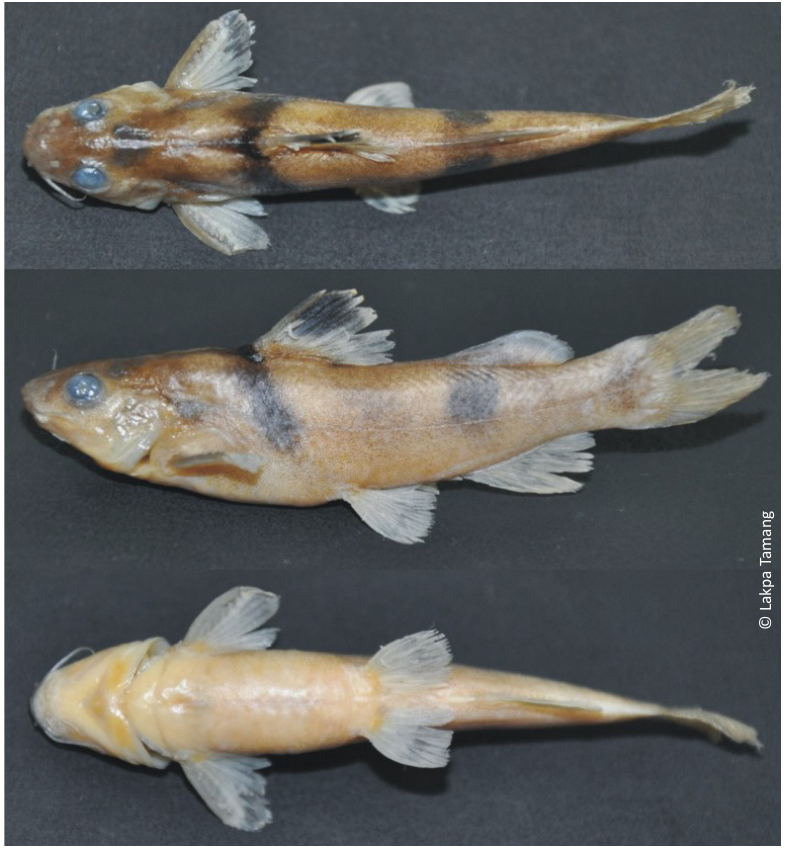
(Figs. 1, 1a-b) [type locality: pond at Mariani Junction, Assam, India, holotype, ZSI